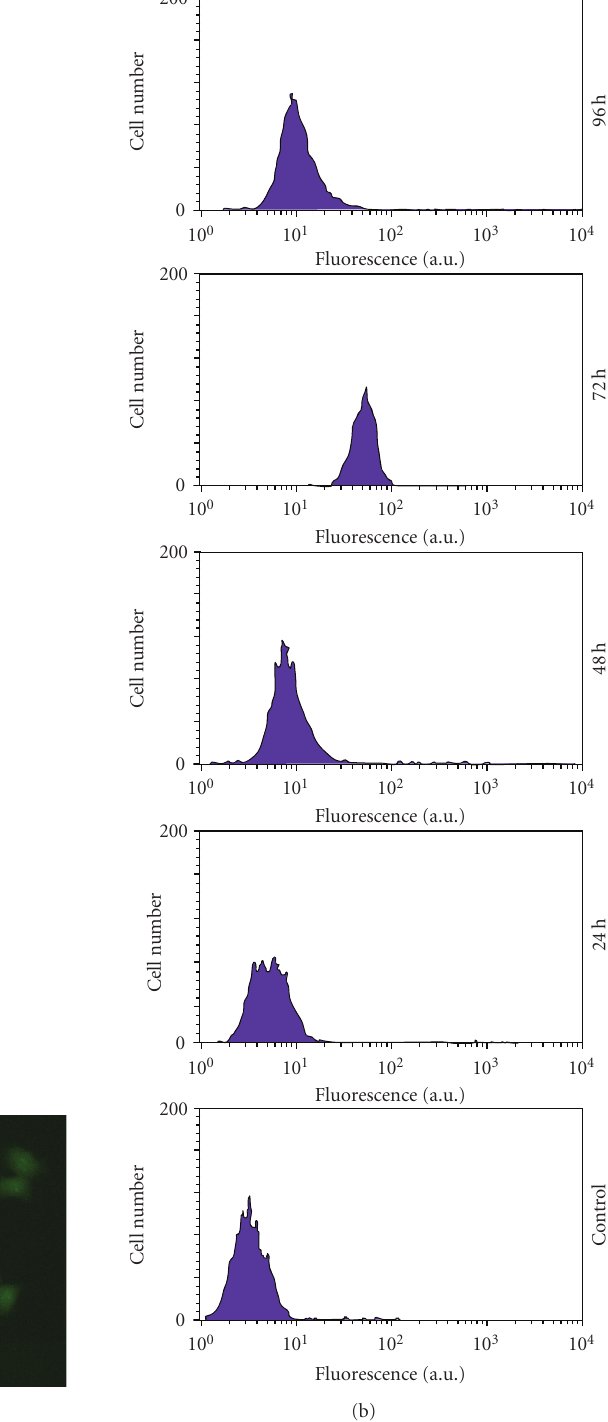
Figure 9: (a) Qualitative evaluation of EGFP-N1 transgene expression in HepG2 cells with chitosan-coated PBCA-NPs, fluorescent image ( × 200) of the cells was obtained after 96 hours upon incubation. (b) Quantitative evaluation of EGFP-N1 transgene expression in HepG2 cells as a function of time measured by flow cytometric analysis with chitosan-coated PBCA-NPs. HepG2 cells without any treatment were used as